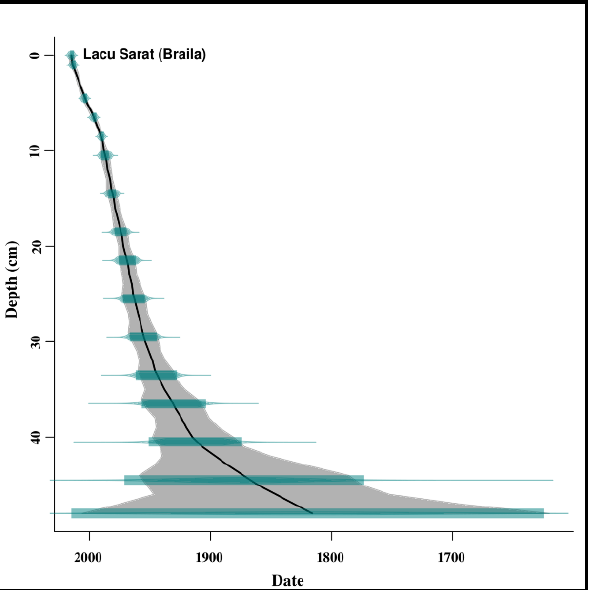
Figure 3. Age-depth model of the sediments from Lacu Sărat Lake. It can be noticed that the deepest part of the investigated sediment cores (48 cm) corresponds to the year 1836.